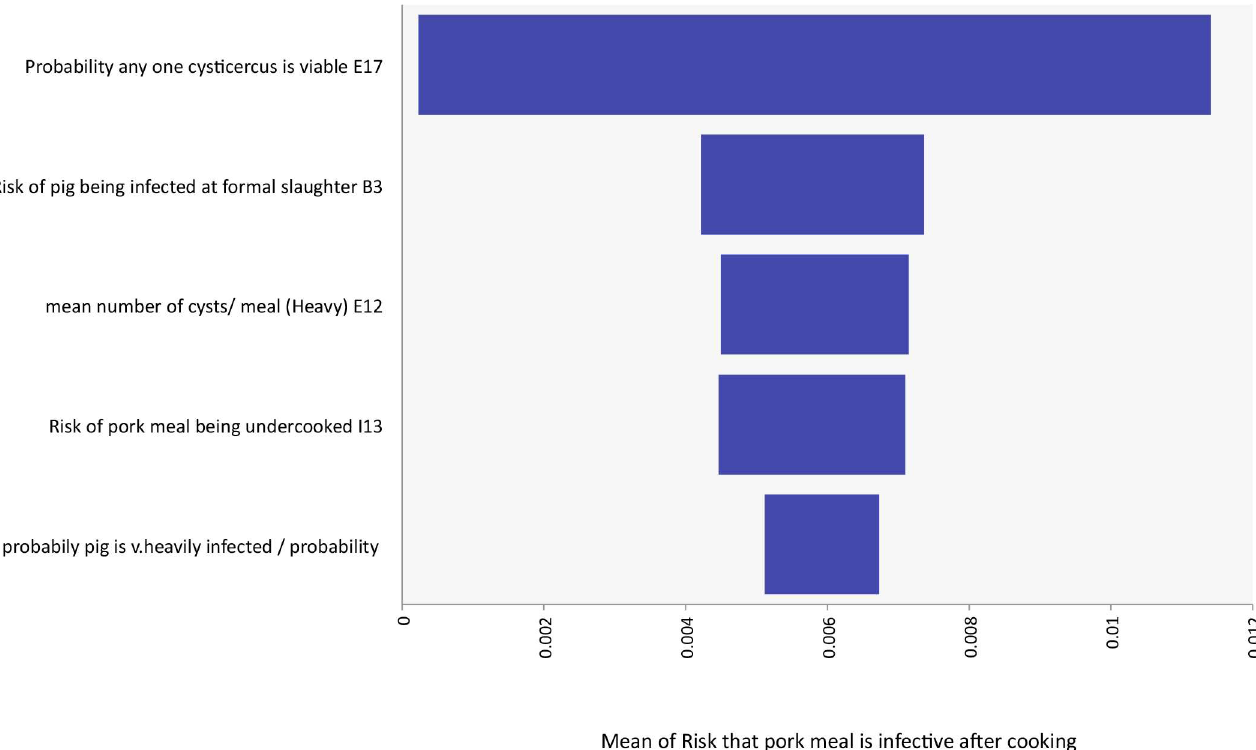
Fig 4. Sensitivity Tornado Graph illustrating change to the mean (Probability any one meal contains a viable cyst after cooking) related to changes in percentiles of input distributions